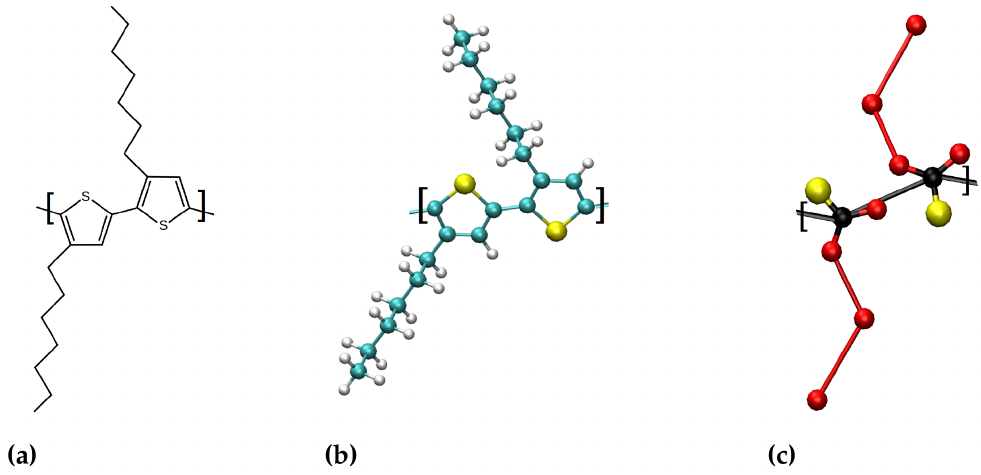
Figure 1. Schematic illustration of P3HT in ( a ), all-atom model in ( b ) and 6-site Martini CG in ( c